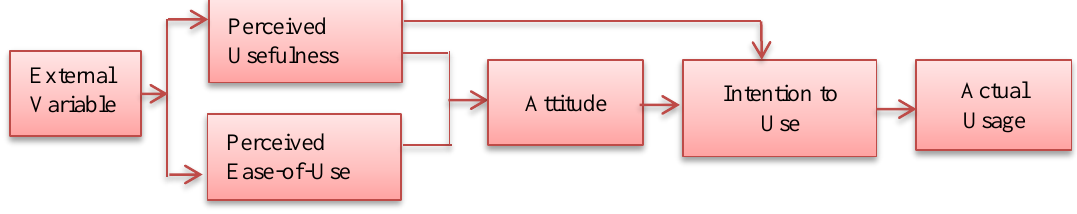
Figure 1. Original technology acceptance model as in Davis